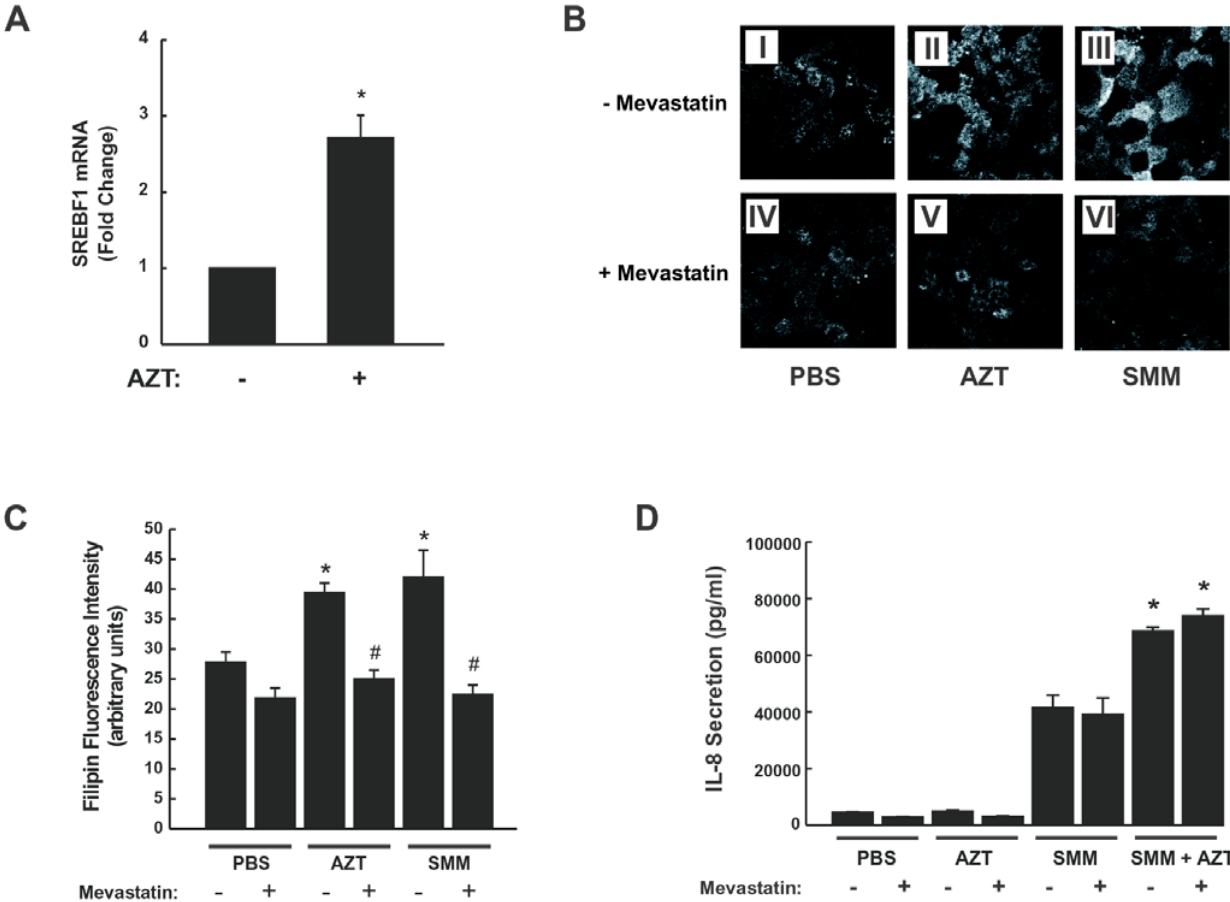
Figure 7. Mucosal bacterial and inflammatory mediator challenge (SMM) or serosal AZT induces accumulation of cholesterol in human airway epithelia. A: Quantitative RT-PCR confirmation of increased SREBP1 levels in AZT-treated cultures. B: Representative filipin stain in WD HBE exposed to 24 hr mucosal PBS (I), 24 hr mucosal SMM (II) or 24 hr 30 m g/ml serosal AZT (III). (IV–VI): Same conditions as in I–III, except that cultures were pretreated with 50 m M mevastatin, as described in Methods. Bar: 10 m m. C: Compiled data from filipin fluorescence from the treatments illustrated in 7B. *p , 0.05 vs. 24 hr PBS-exposed HBE; # p , 0.05 vs. same condition without mevastatin pretreatment. D: IL-8 secretion induced by SMM or by SMM in presence of AZT is not affected by inhibition of cholesterol biosynthesis. Well-differentiated HBE were exposed for 24 hr